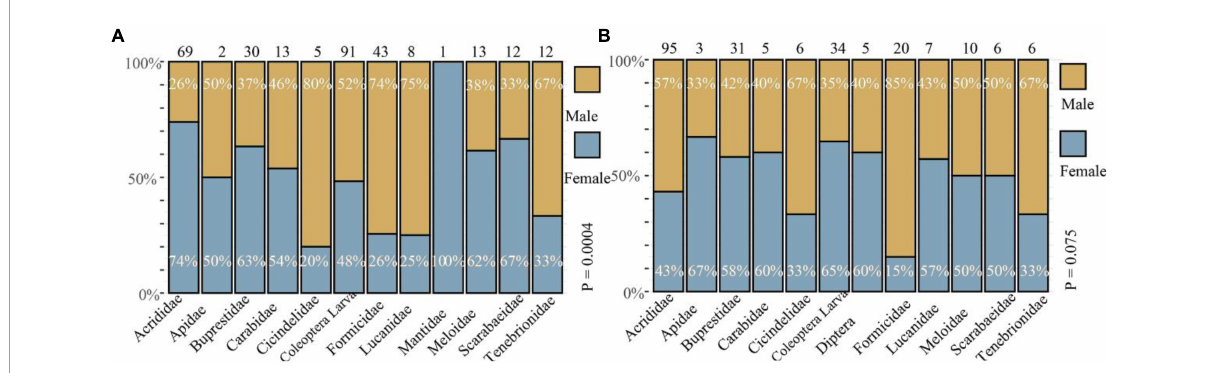
FIGURE4 Frequency of prey composition (%) between the two sexes of Eremias grammica (A) and E. velox (B) . The number in each histogram represents the total number of prey items. The top values indicate the proportion of males, while the bottom values indicate that of females.